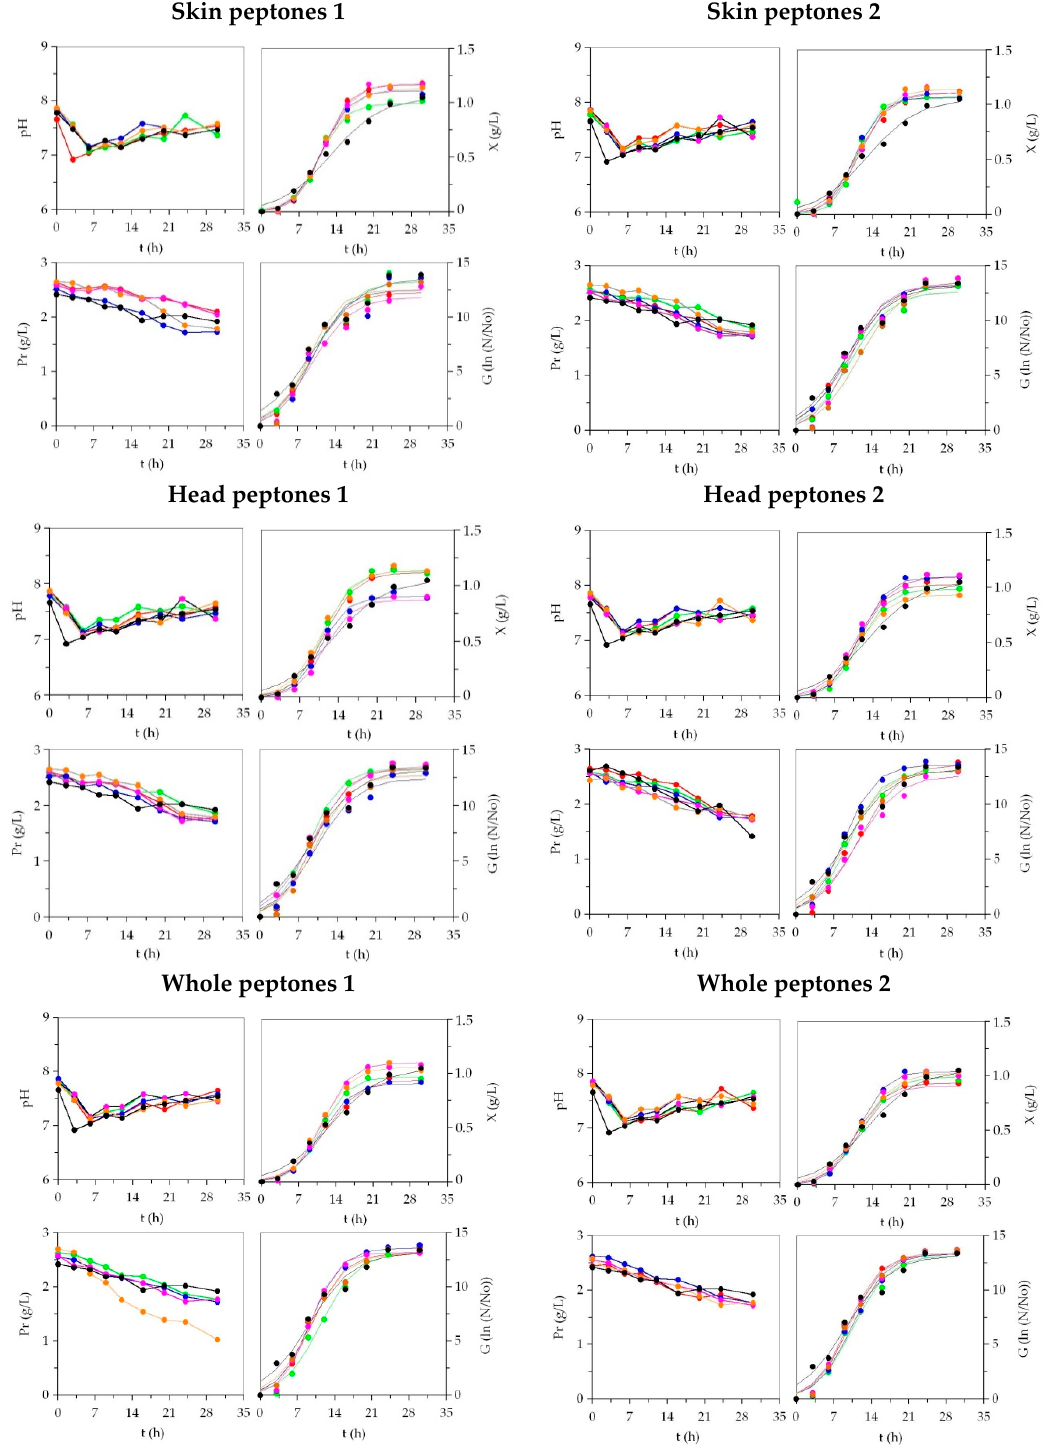
Figure 3. Culture kinetics of P. fluorescens in marine media based on marine peptones from discarded fish and by-products. Peptones 1: (cid:145) : BW; (cid:145) : RS; (cid:145) : Ma; (cid:145) : Po; (cid:145) : Gu; (cid:145) : MM1. Peptones 2: (cid:145) : Gr; (cid:145) : Me; (cid:145) : Ha; (cid:145) : Bo; (cid:145) : AHM; (cid:145) : MM2. Experimental data of biomass ( X ) and viable cells ( G ) were fitted to the logistic equation. Protein (Pr) uptakes and pH were also shown. The confidence intervals of experimental data (for two replicates) were in all cases less than 20% of the experimental mean values and omitted for clarity.